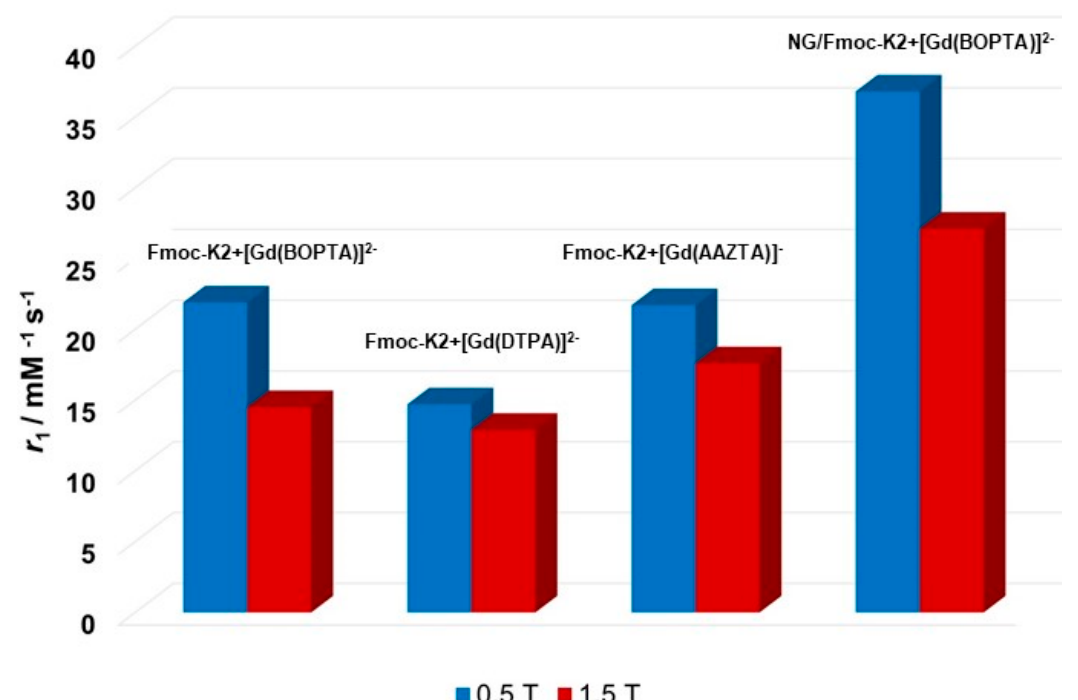
Figure 3. 1 H NMRD profiles of Fmoc-K2+[Gd(BOPTA)] 2 − ( A ), Fmoc-K2+[Gd(DTPA)] 2 − ( B ) and Fmoc- K2+[Gd(AAZTA)] − ( C ) at 283 (blue), 298 (black) and 310 K (red). The profiles of the corresponding chelates in aqueous solution are also reported as solid lines.